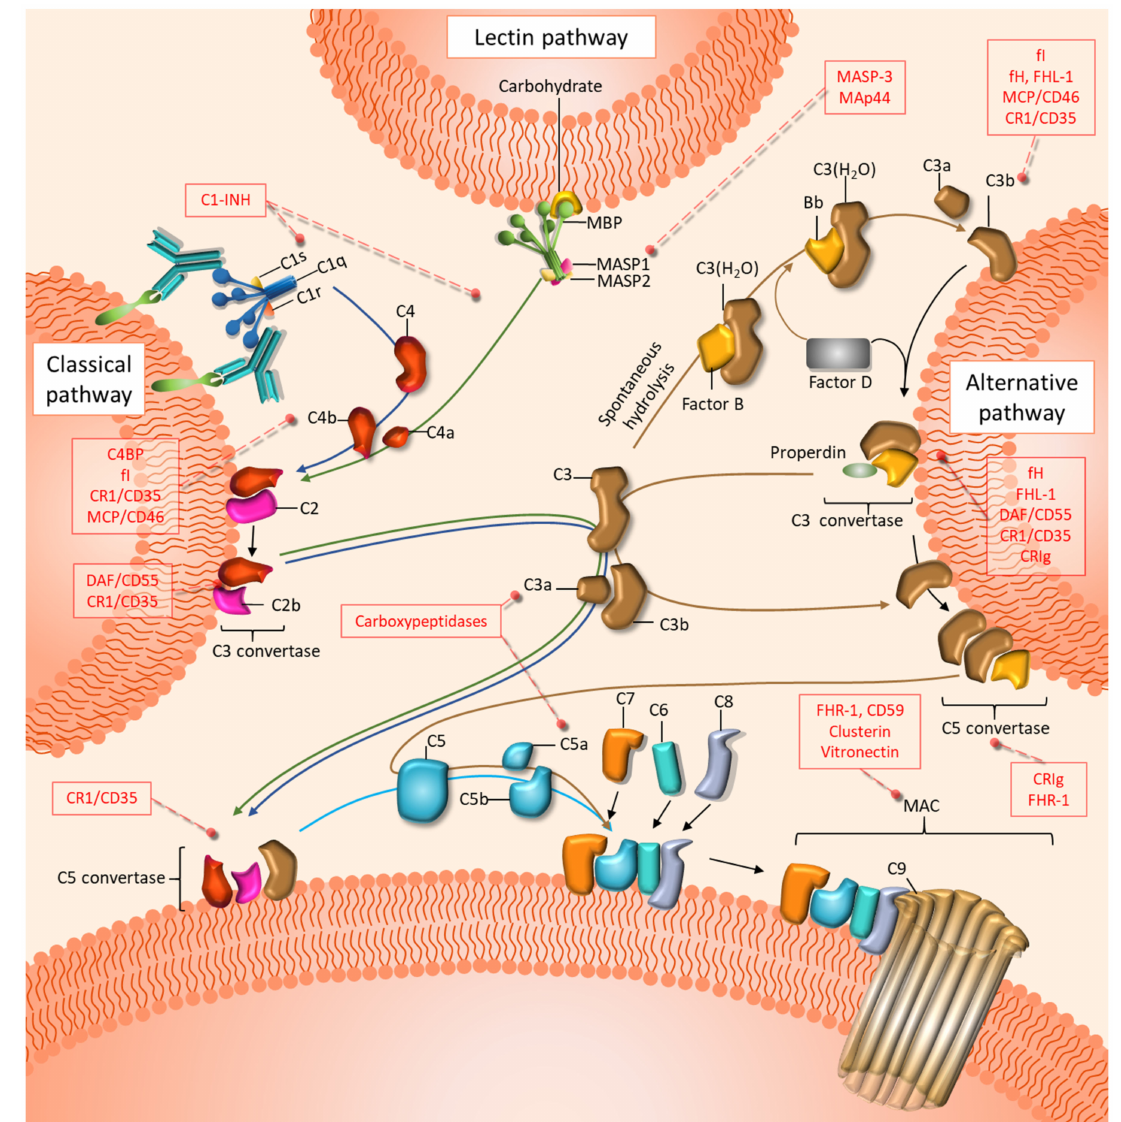
Figure 1. Schematic representation of the effectors and regulators of the complement cascade. Complement is initiated by three distinctive pathways: the classical (blue arrows), the lectin (green arrows), and the alternative (brown arrows) pathways. All three pathways converge in the formation of C3 and C5 convertases, which in turn generate the inflammation modulators C3a and C5a. The terminal steps, which culminate in the assembly of the membrane attack complex (MAC), are common to the three pathways. Inhibitory proteins of the three pathways are shown in red